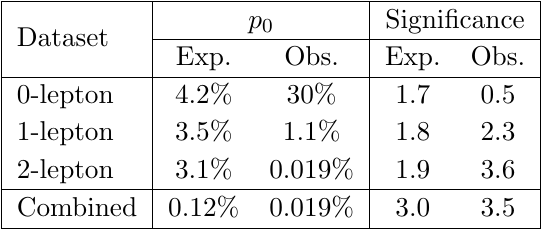
Table 14 . The expected and observed p 0 and signi(cid:12)cance values (in standard deviations) for the individual lepton channels and their combination using the 13 TeV dataset. The expected values are evaluated assuming a SM Higgs boson with a mass of 125